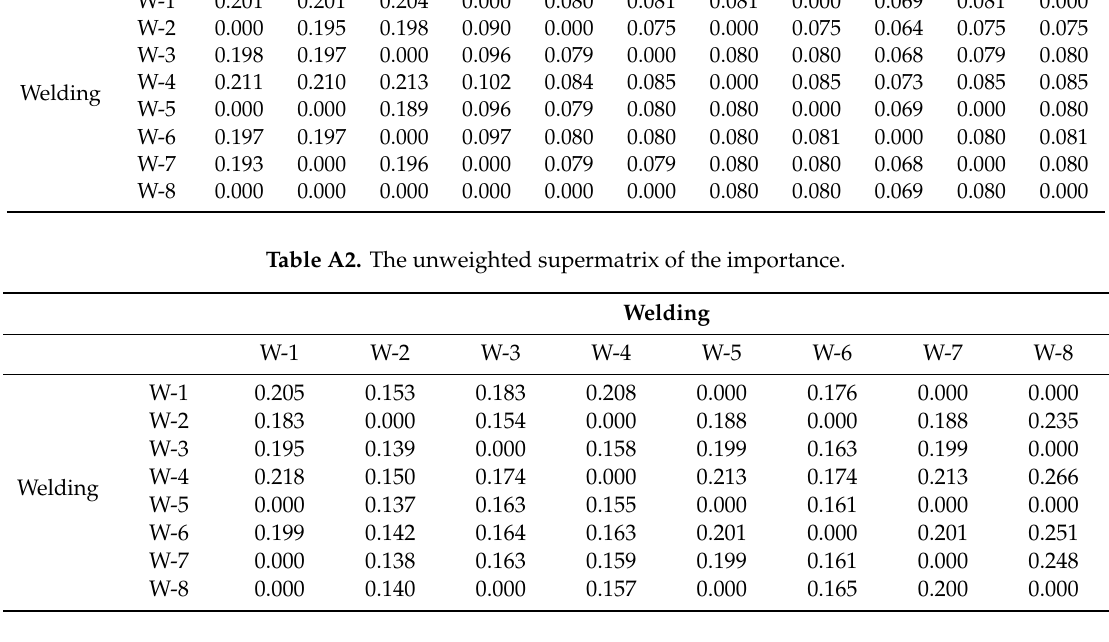
Table A3. The weighted supermatrix of the